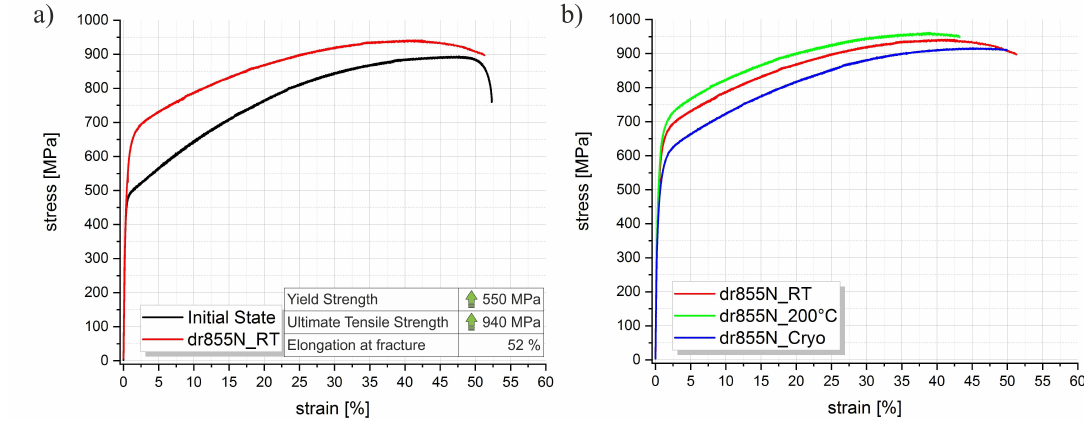
Figure 5. Monotonic stress–strain response of the as-received material compared to a specimen deep rolled at room temperature using a deep rolling force of 855N ( a ) and direct comparison of the conditions deep rolled at different temperatures applying the same deep rolling force ( b